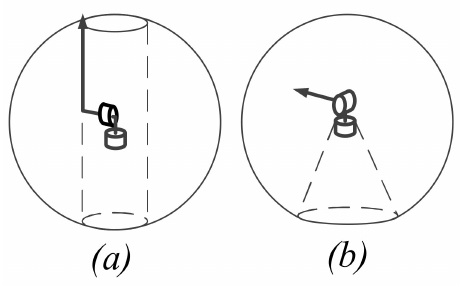
Figure 2. DOF assignment scheme for end effectors. ( a ) with a cylinder blind area; ( b ) with a cone blind area.